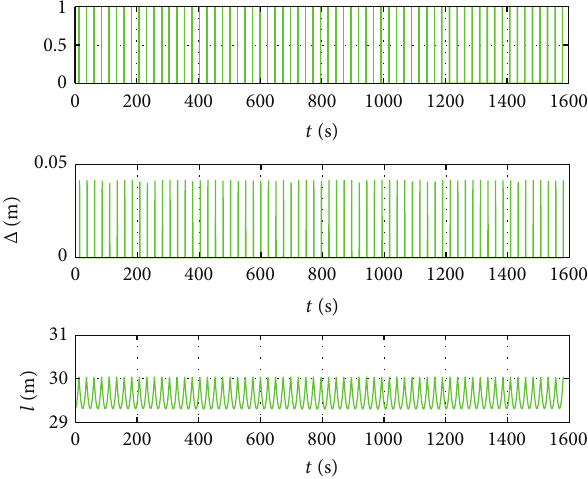
Figure13:Thetensional( 1 )andtensionless(0)states,theelongation of the tether ( Δ ), and the distance ( 𝑙 ) between the two spacecraft.